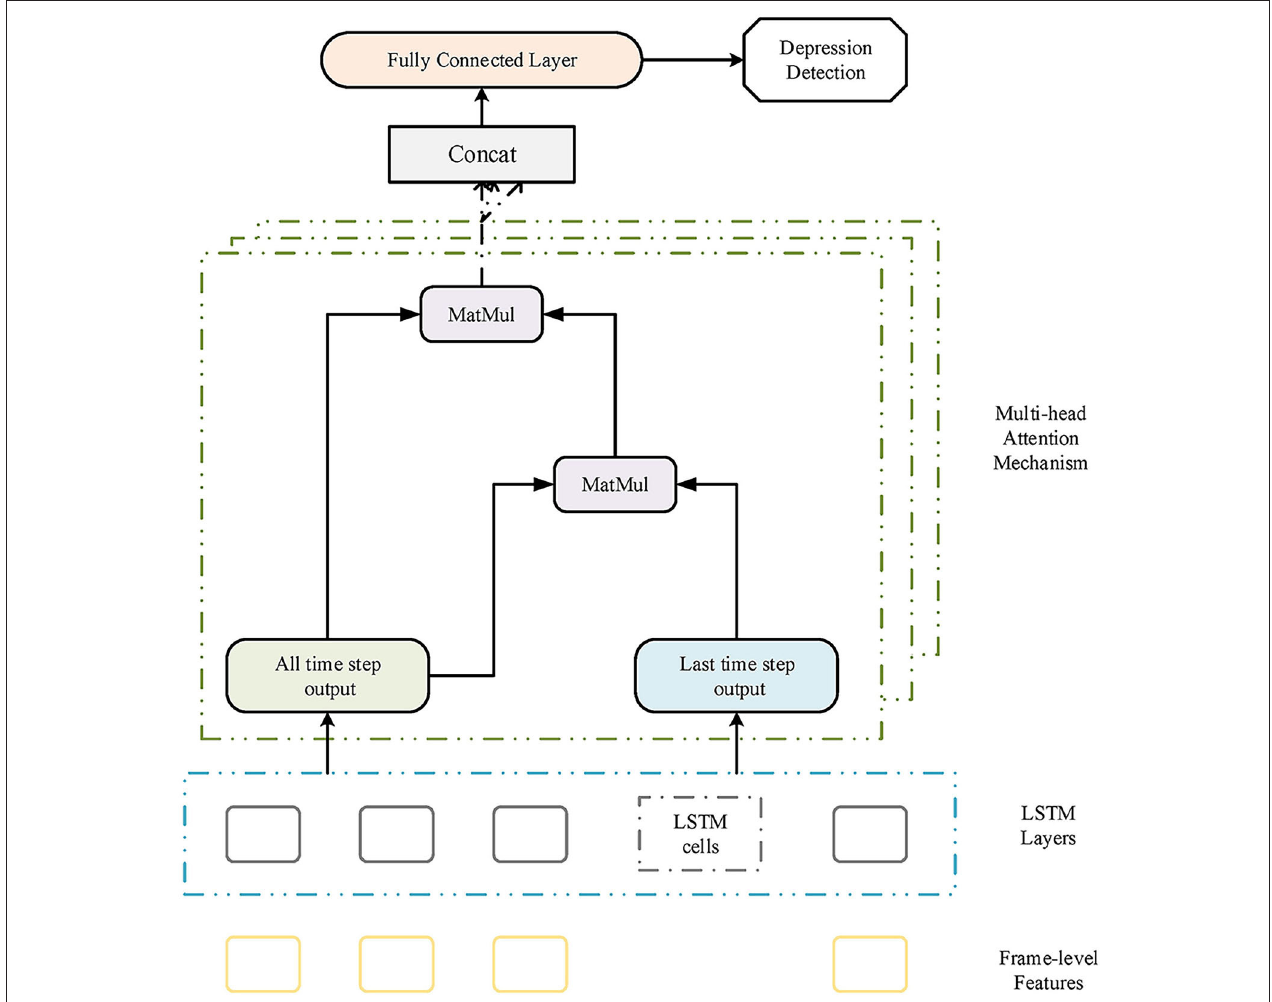
FIGURE 4 | The structure of the proposed multi-head attention-based long short-term memory (LSTM) model.